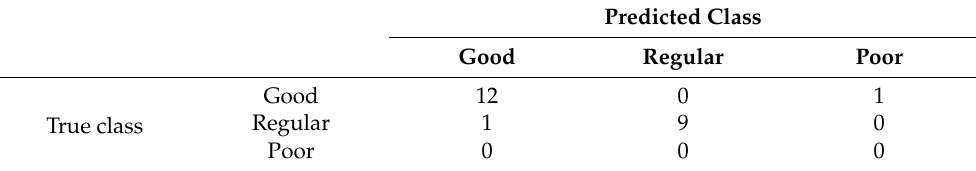
Table 11. Confusion matrix of the proposed meta-learning for the Naïve Bayes classifier.